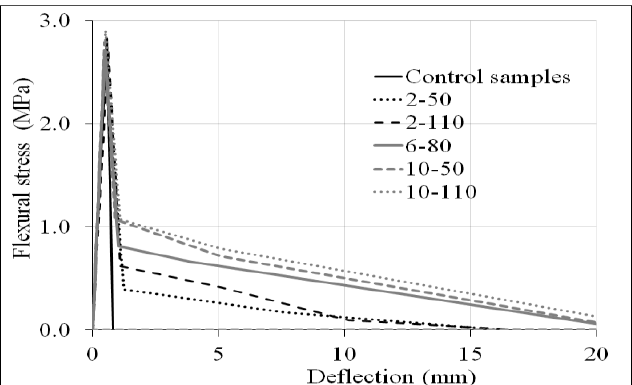
Figure 14. Flexural test.